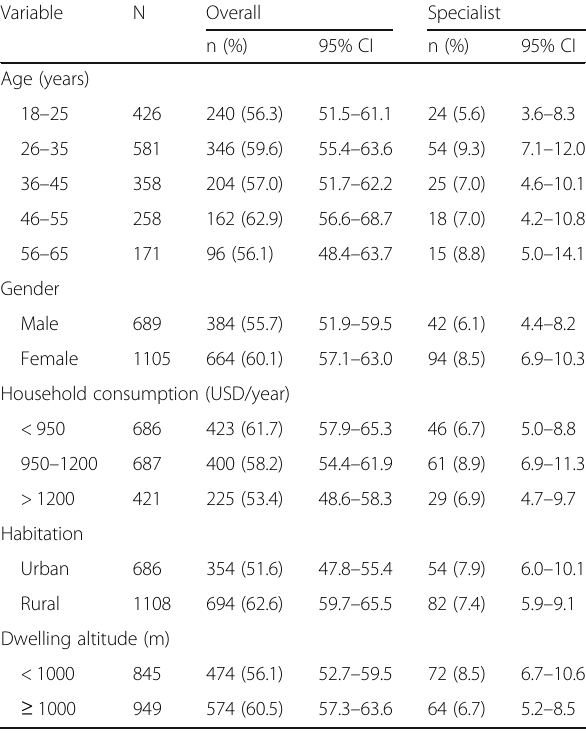
Table 3 Medical consultation by age, gender, household consumption, habitation and dwelling altitude